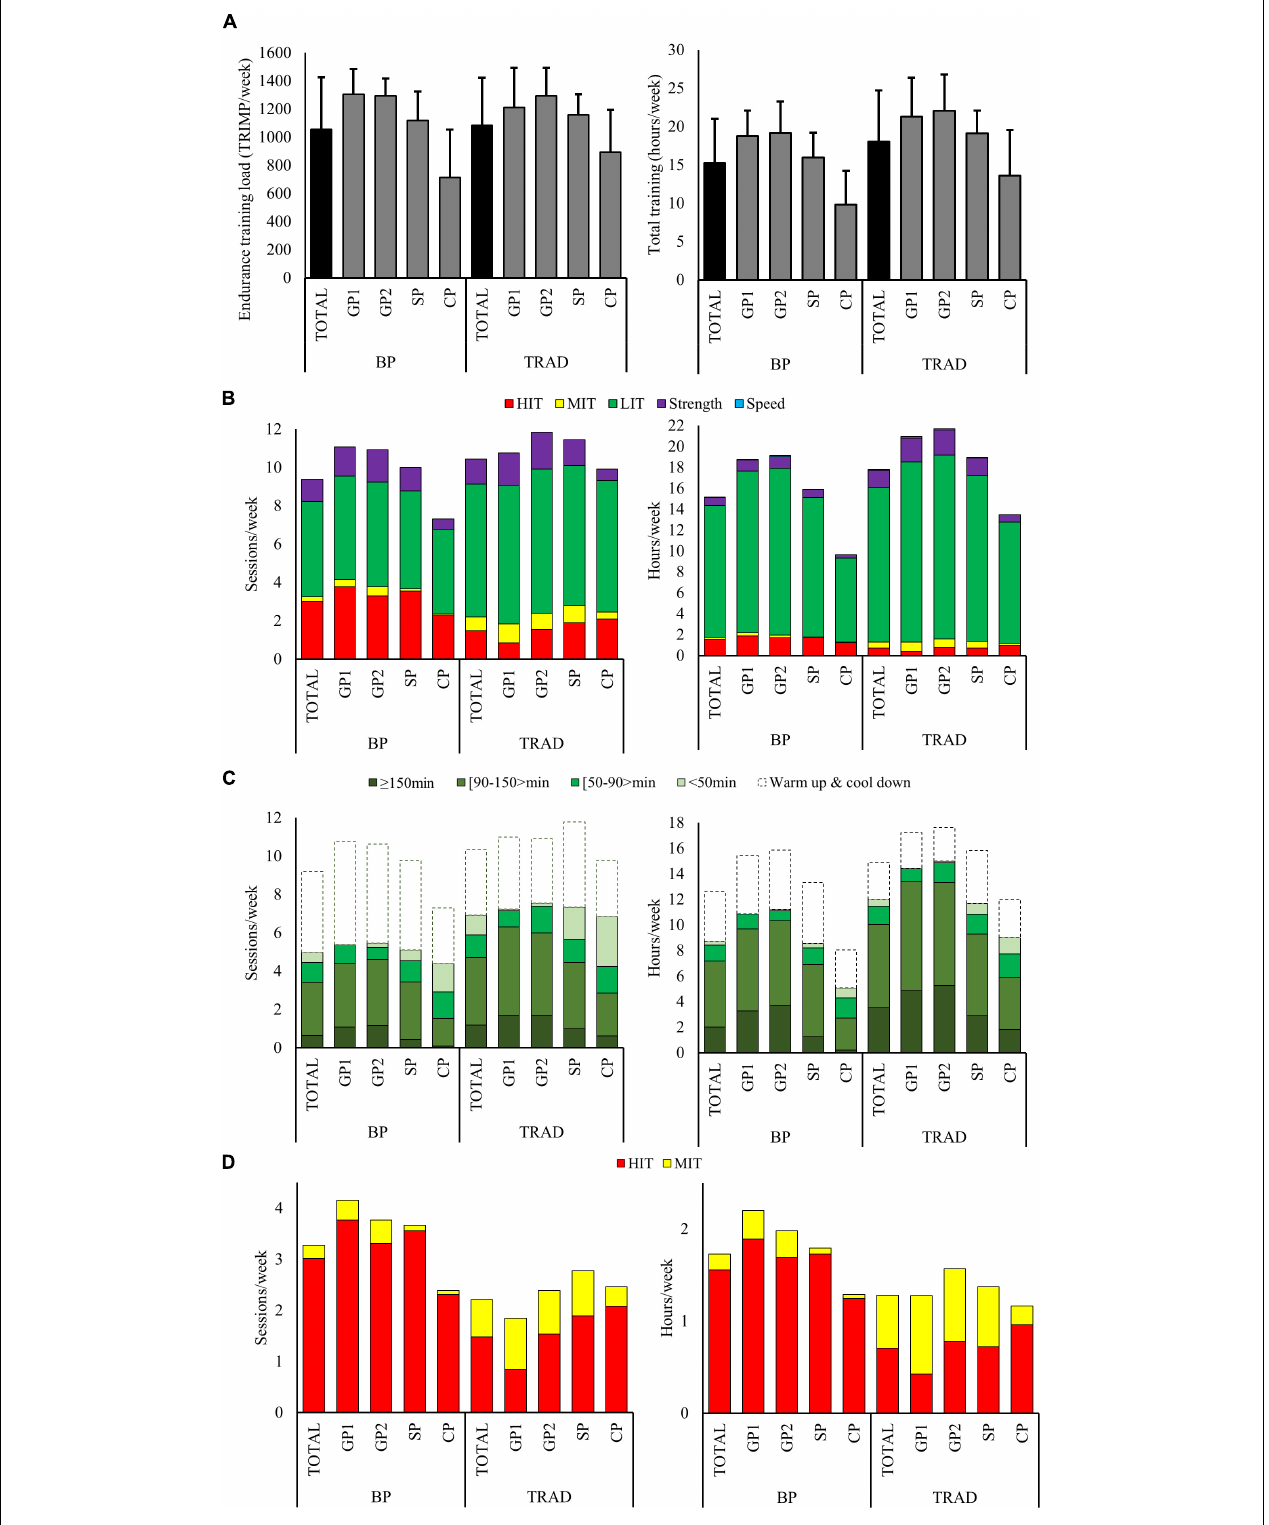
FIGURE 1 | The distribution of the total training volume and endurance training load (A) , intensity distribution (B) , low (LIT) (C) , moderate (MIT), and high-intensity training (HIT) (D) across the annual cycle (TOTAL), and the different phases [general preparation (GP), specific preparation (SP) and competition phase (CP)], in the season using block periodization of HIT (BP) and the season using traditional periodization (TRAD).